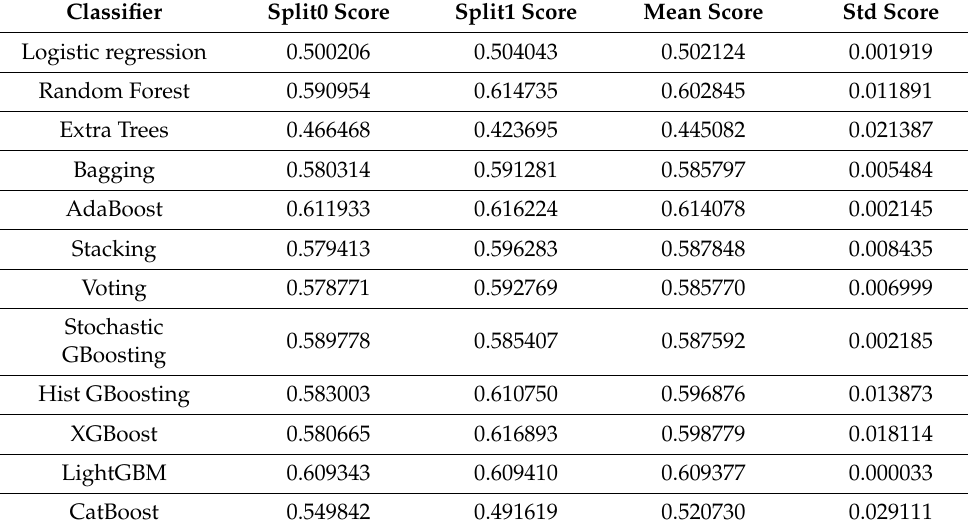
Table 6. Two-fold time-series cross-validation (G-mean